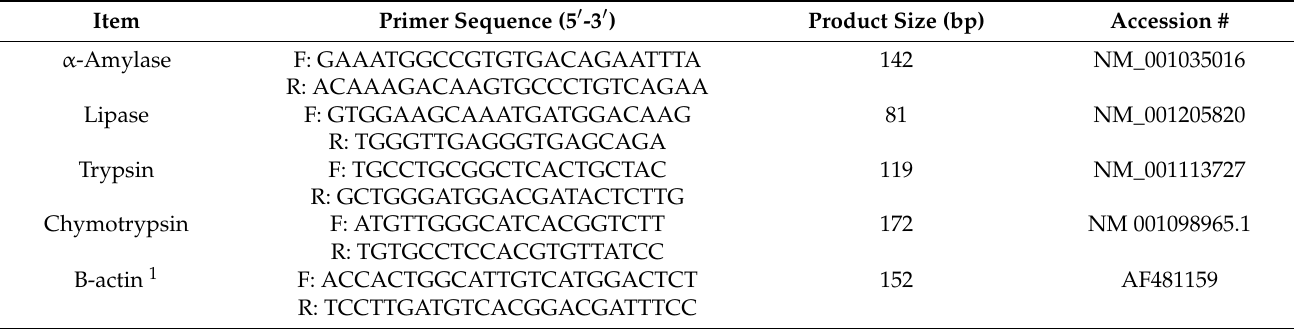
Table 2. The PCR primers used to amplify genes encoding α -amylase, lipase, trypsin, and